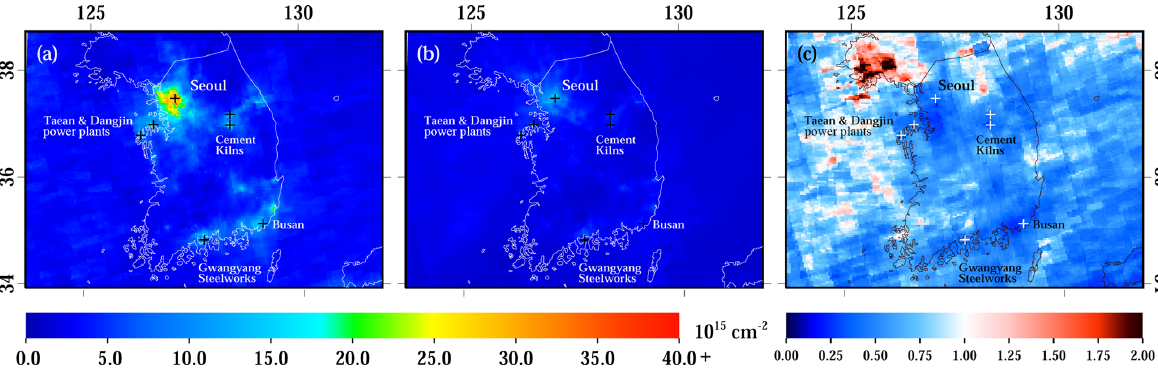
Figure 3. (a) The OMI-regional NO 2 product with the air mass factor adjustment and spatial kernel averaged during the month of May 2016, (b) the WRF-Chem model simulation showing only days with valid OMI measurements, and (c) the ratio between the two products. On average, there are only nine valid OMI pixels per month observed at any given location on the Korean Peninsula during May